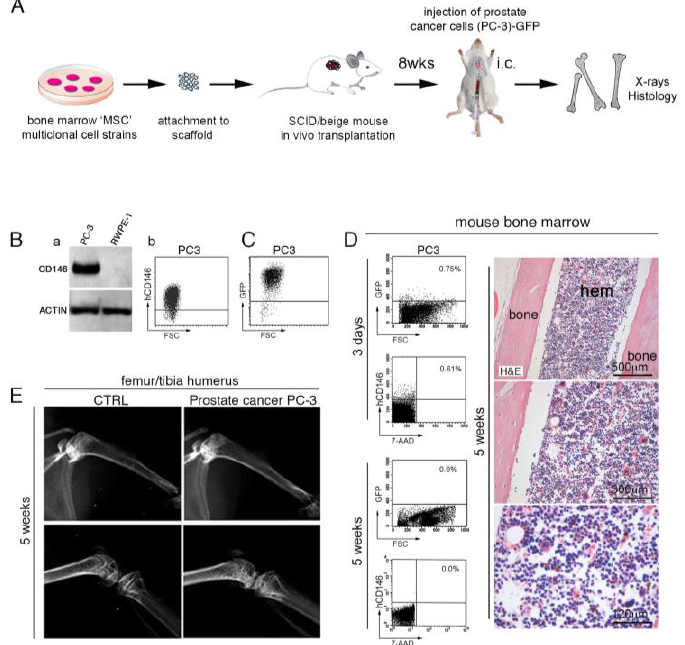
Figure 3. ( A ) human PC-3 and RWPE-1 cells were intracardiac (i.c.) or intra-tail vein (i.v.) injected in mice bearing heterotopic humanized bone / BM ossicles. ( B ) Western blot analysis of PC3 and RWPE-1 cell lysates. β -actin was used as control (a). Fluorescent Activated Cell Sorting (FACS) analysis of PC3 cells stained with anti-human CD146 (b). ( C ) GFP expression of PC-3 cells performed before i.c. injection of SCID / beige mice. ( D ) I.c. injected PC3 cells not survive and growth in murine BM. Representative FACS analysis for human CD146 and GFP in murine BM three days and five weeks after i.c. injection of 1 × 10 6 PC3 cells show that human PC3 cells reach murine BM, but do not survive or generate histologically detectable metastatic deposits. PC-3 cells are refractory to colonize murine bone/BM. Scale bars represent 120, 300, 500 μm as indicated. ( E ) X-ray analysis did not detect any